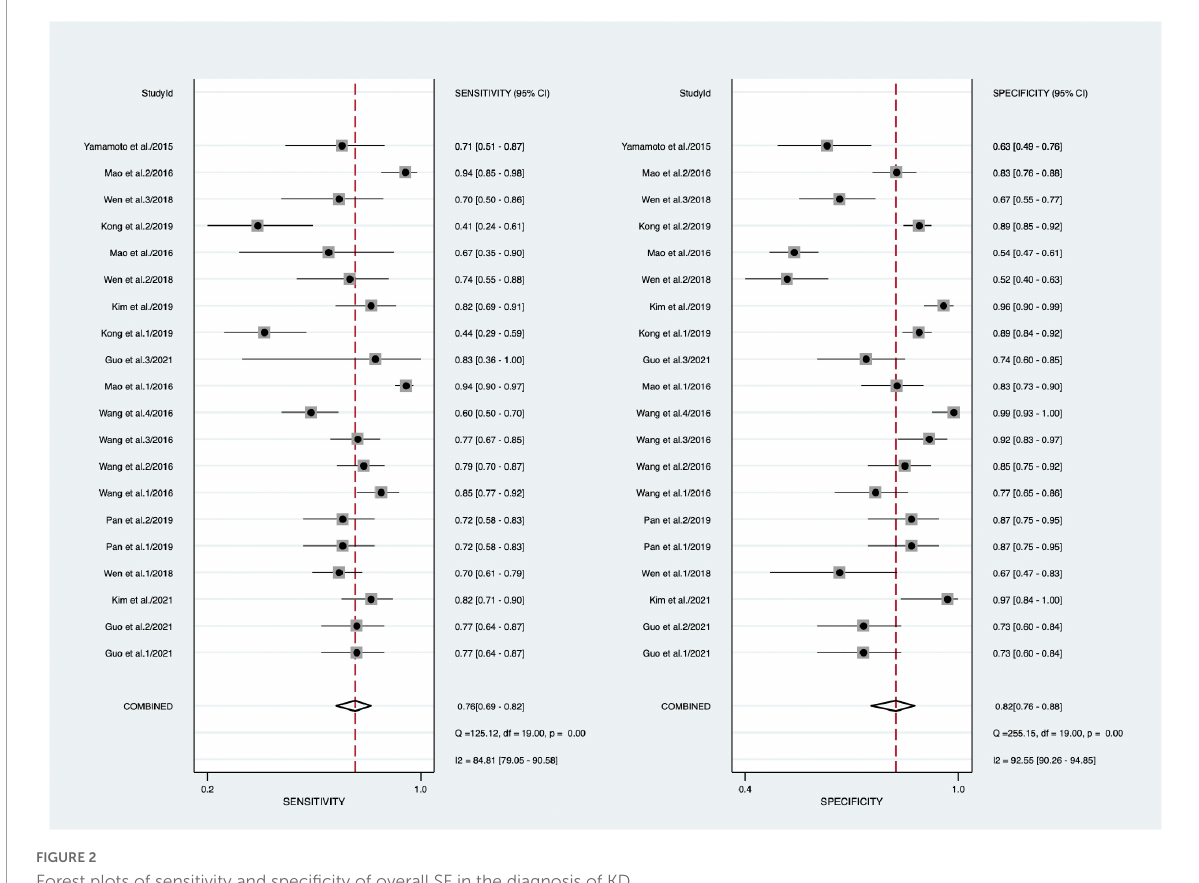
FIGURE2 Forest plots of sensitivity and specificity of overall SF in the diagnosis of KD.